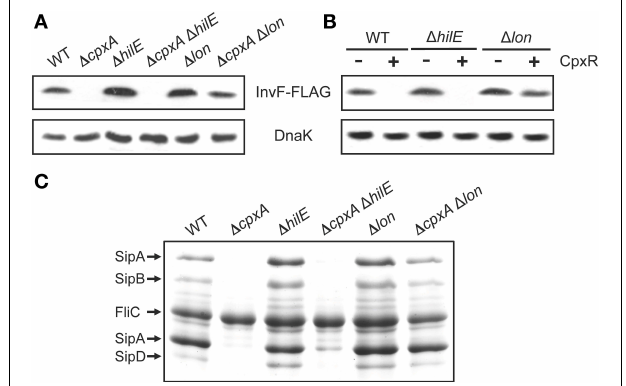
FIGURE 5 | Repression of the SPI-1 genes by CpxR is lost in the absence of the Lon protease. Expression of the SPI-1-encoded InvF-FLAG in the WT S . Typhimurium strain and its isogenic 1 cpxA , 1 hilE, 1 cpxA 1 hilE, 1 lon and 1 cpxA 1 lon mutants (A) , or in the WT S . Typhimurium strain and its isogenic 1 hilE and 1 lon mutants carrying plasmid pCA-CpxR (C) , was analyzed by Western blotting using monoclonal anti-FLAG antibodies. Whole cell lysates were prepared from samples of bacterial cultures grown for 5h in LB medium at 37 ◦ C. As a loading control, the expression of DnaK was also determined using monoclonal anti-DnaK antibodies. Overexpression ( + ) of CpxR from the T5-lac promoter of plasmid pCA-CpxR was induced by adding 50 µ M IPTG at the beginning of the bacterial cultures. (B) Secretion analysis of the SPI-1-encoded proteins SipA, SipB, SipC, and SipD was tested in the WT S . Typhimurium strain and its isogenic 1 cpxA , 1 hilE, 1 cpxA 1 hilE, 1 lon, and 1 cpxA 1 lon mutants grown for 9h in LB medium at 37 ◦ C. FliC is a flagellar protein whose secretion is